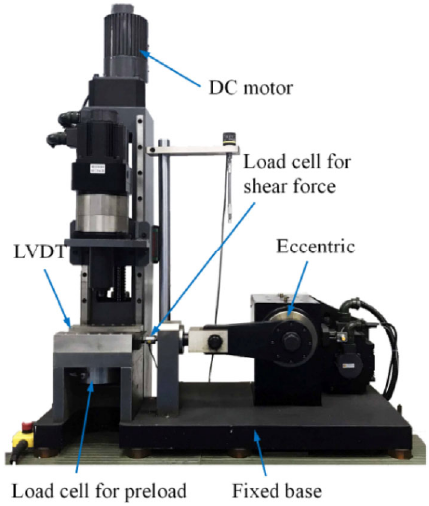
Fig. 22 Junker test machine. Reproduced with permission from Ref. [22], © Elsevier Ltd. 2020.